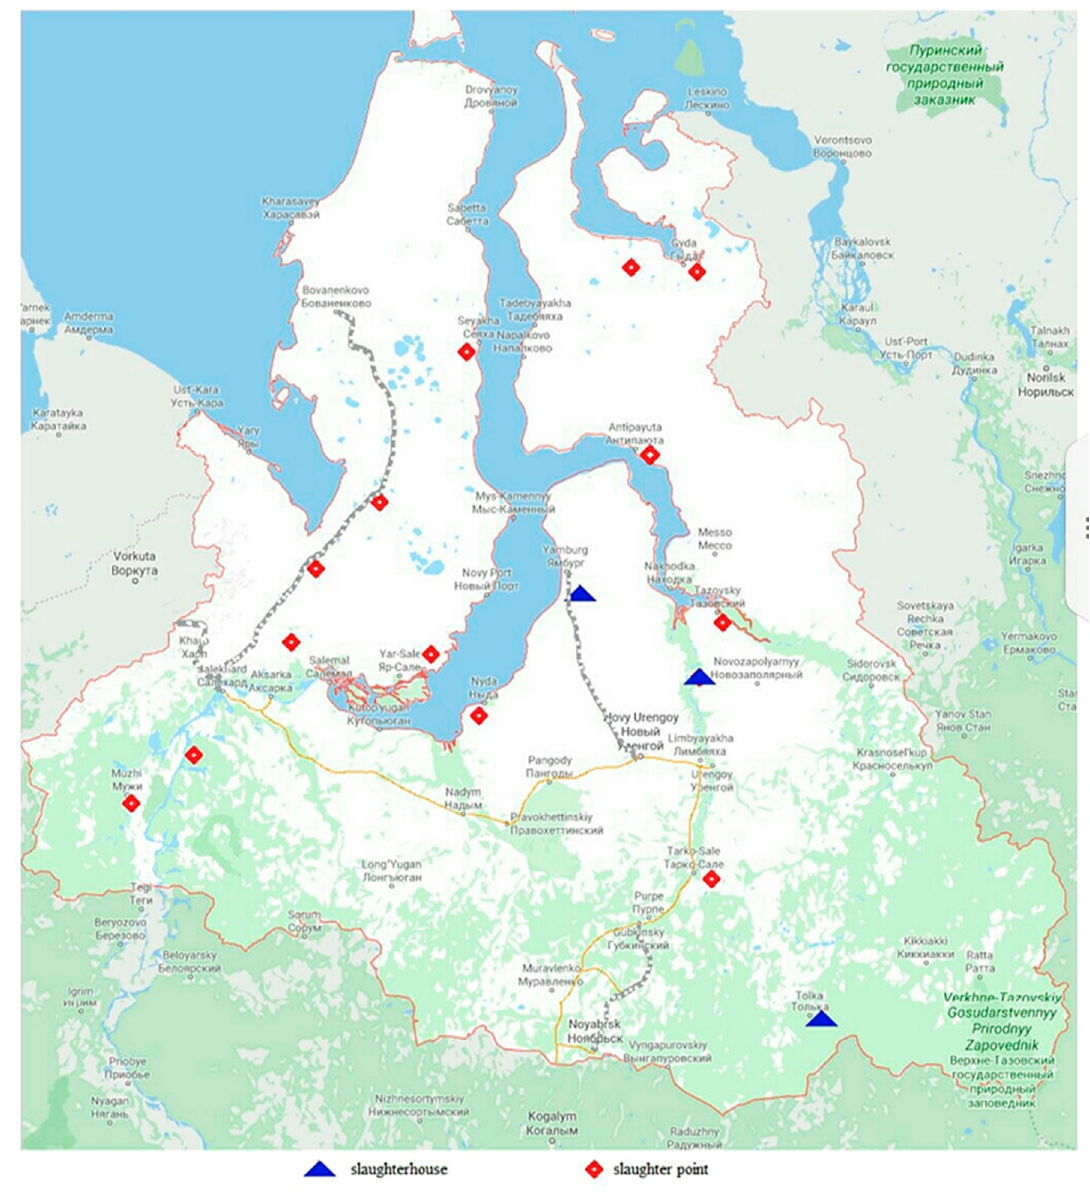
Figure 1. The territory of the Yamal-Nenets Autonomous